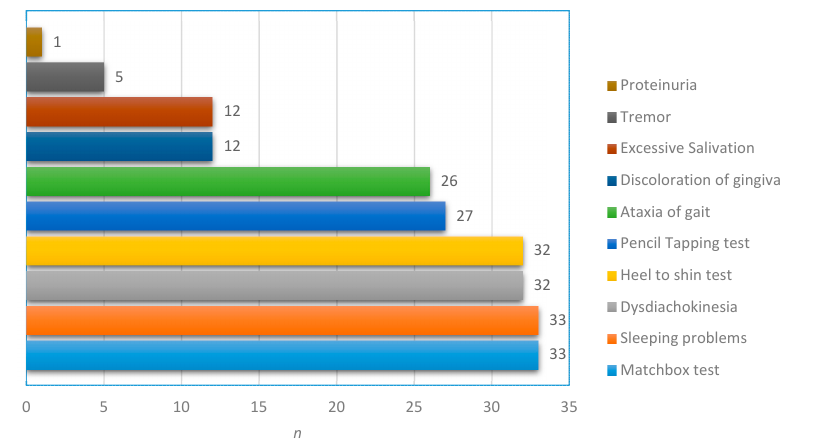
Figure 3. Frequencies of medical score symptoms and positive test results within subgroup ( n = 36).